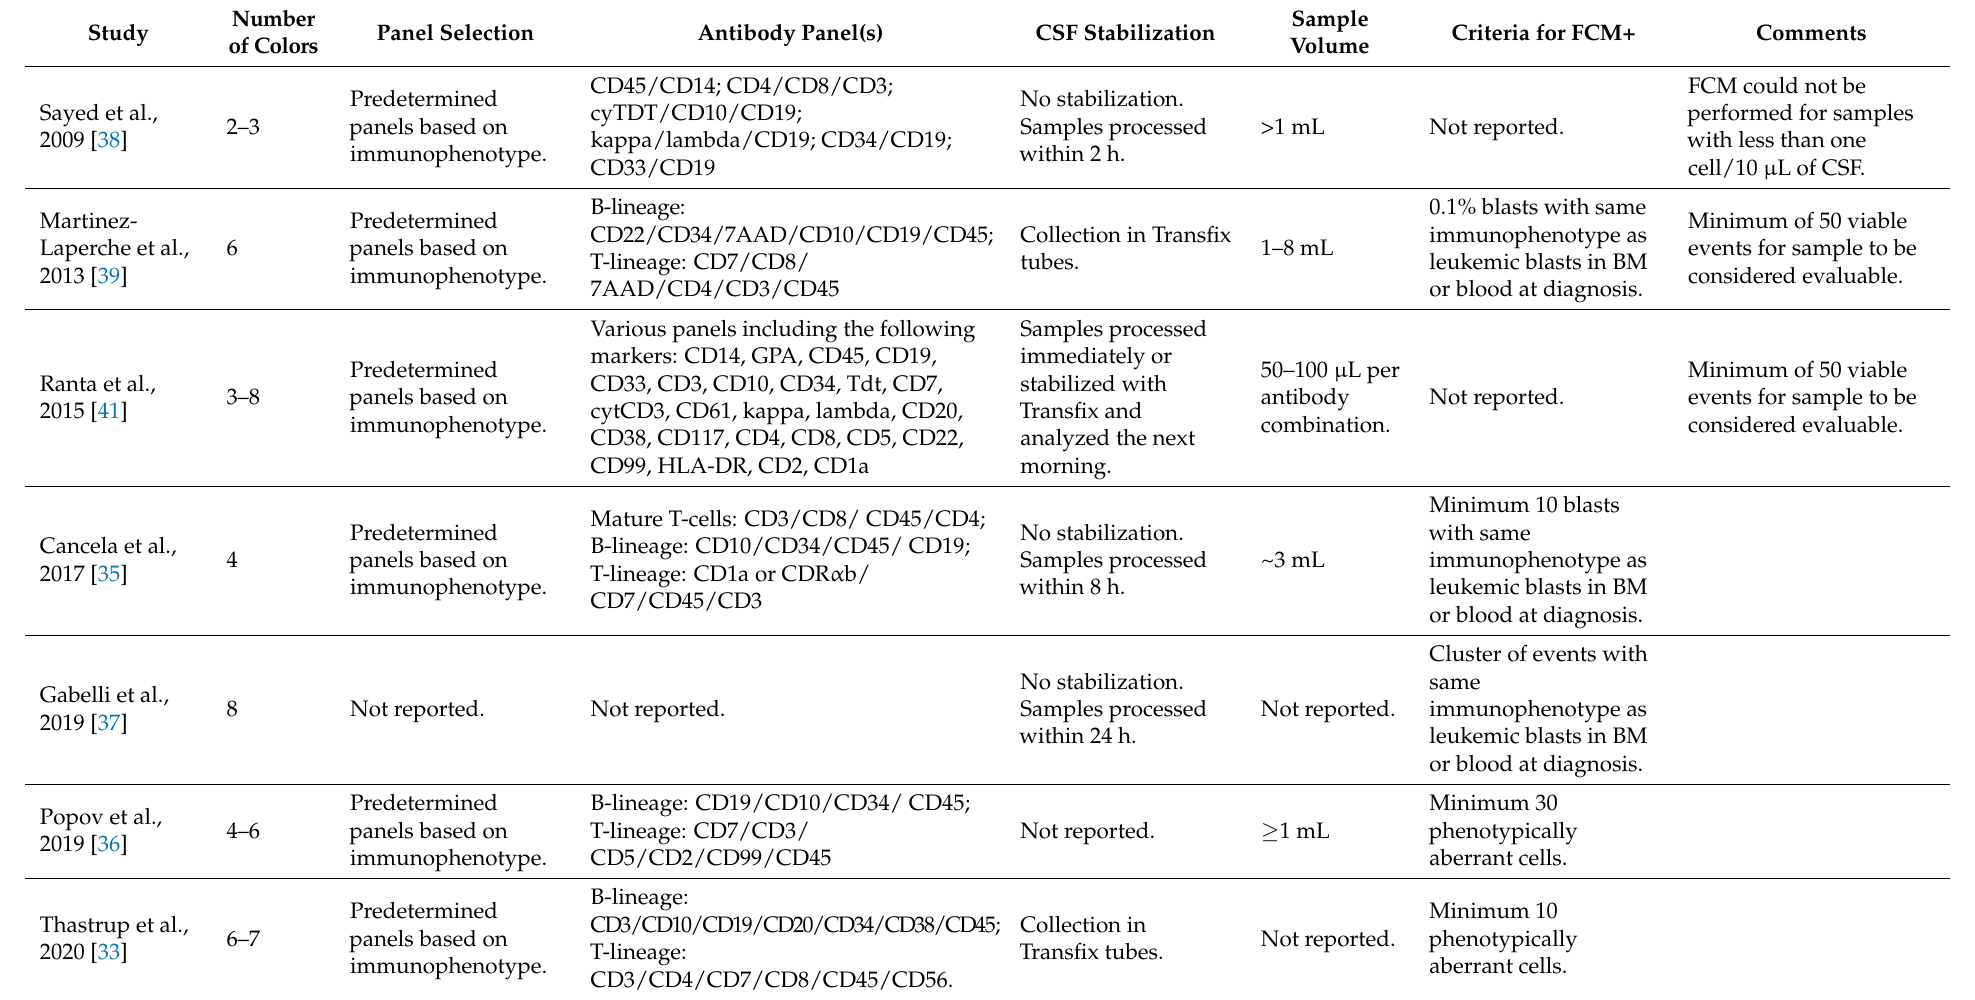
Table 1. Flow cytometric methodology for CSF analysis in childhood ALL studies. CSF: cerebrospinal fluid; FCM: flow cytometry; BM: bone